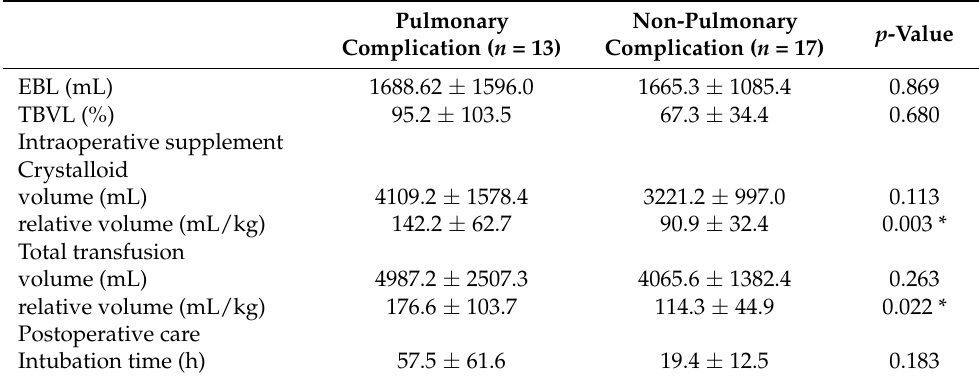
Table 3. Comparison of operative variables between postoperative pulmonary complication group and non-pulmonary complication